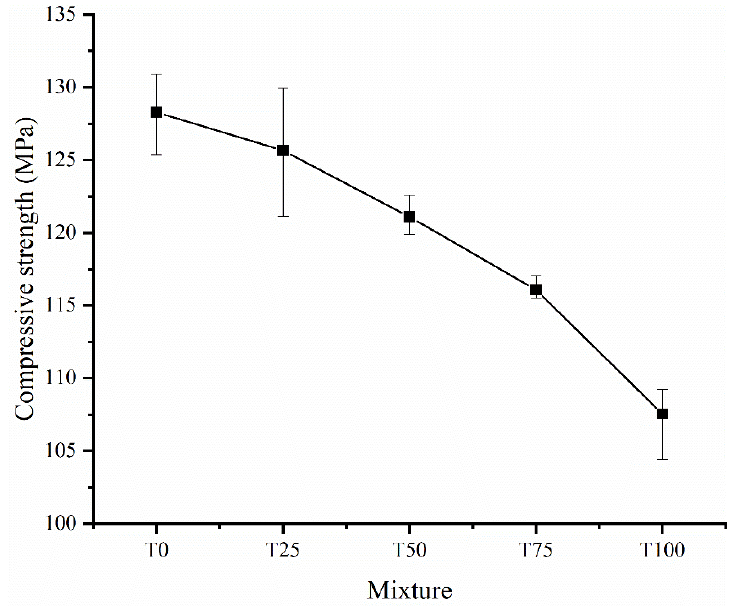
Figure 11. Effect of iron tailings on the compressive strength of UHPC.